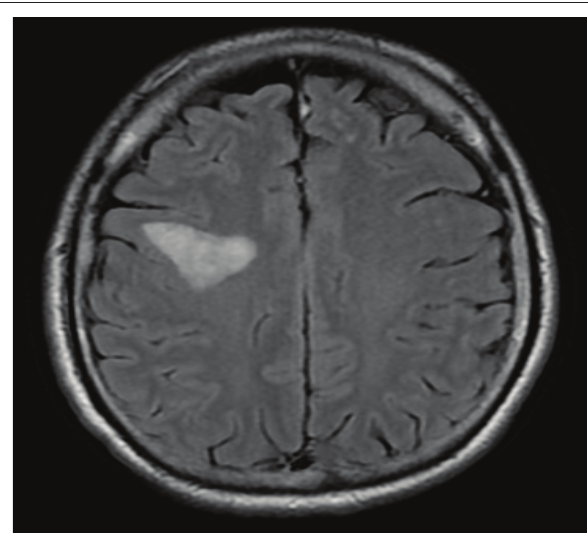
FIGURE 1: Axial FLAIR MR image.